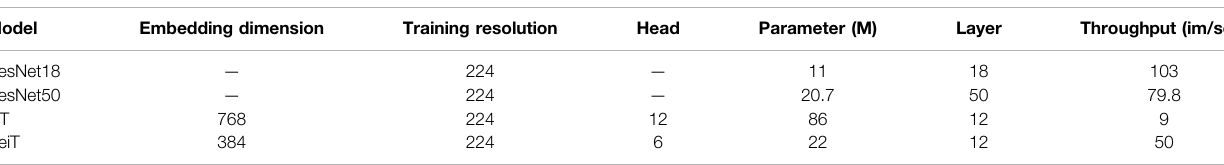
TABLE 4 | Characteristic of different models.